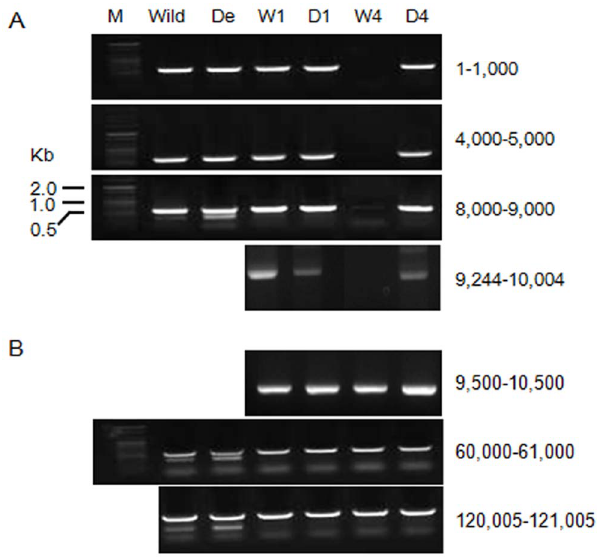
Figure 5. Synteny analysis of the genomic regions of D4 and W1 specific to the degenerate strain. (A) DNA fragment of the W4 and D4 genomic region corresponding to 1 to 10 kb of scaffold 59 from the F. velutipes monokaryotic strain (Mono3) obtained by PCR using the SCAR primer set (FEDE-F and -R). Wild: Fv1-5 (wild-type), De: Fv1-5 d (degenerate). W1 to W6 are monokaryons from Fv1-5, and D1 to D6 are monokaryons from Fv1-5 d . W1–W3: group a ( AxBy ), W4–W6: group b ( AyBx ), D1–D3: group a d ( AxBy ), D4–D6: group b d ( AyBx ). (B) DNA fragment of the W4 and D4 genomic region corresponding to 60 to 121 kb of scaffold 59 obtained by PCR using the SCAR primer set.